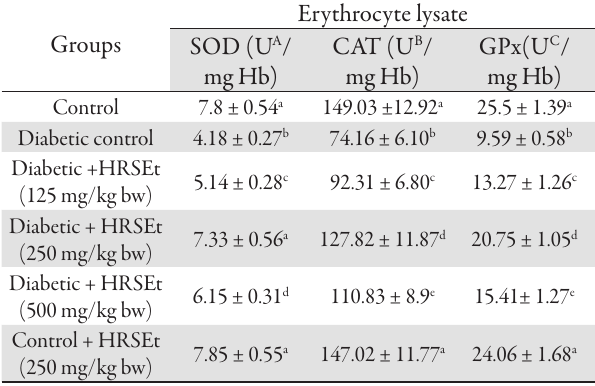
Tab. 6. Effect of HRSEt on the activities of enzymatic antioxidants in the erythrocyte lysate of control and STZ induced diabetic rats Groups